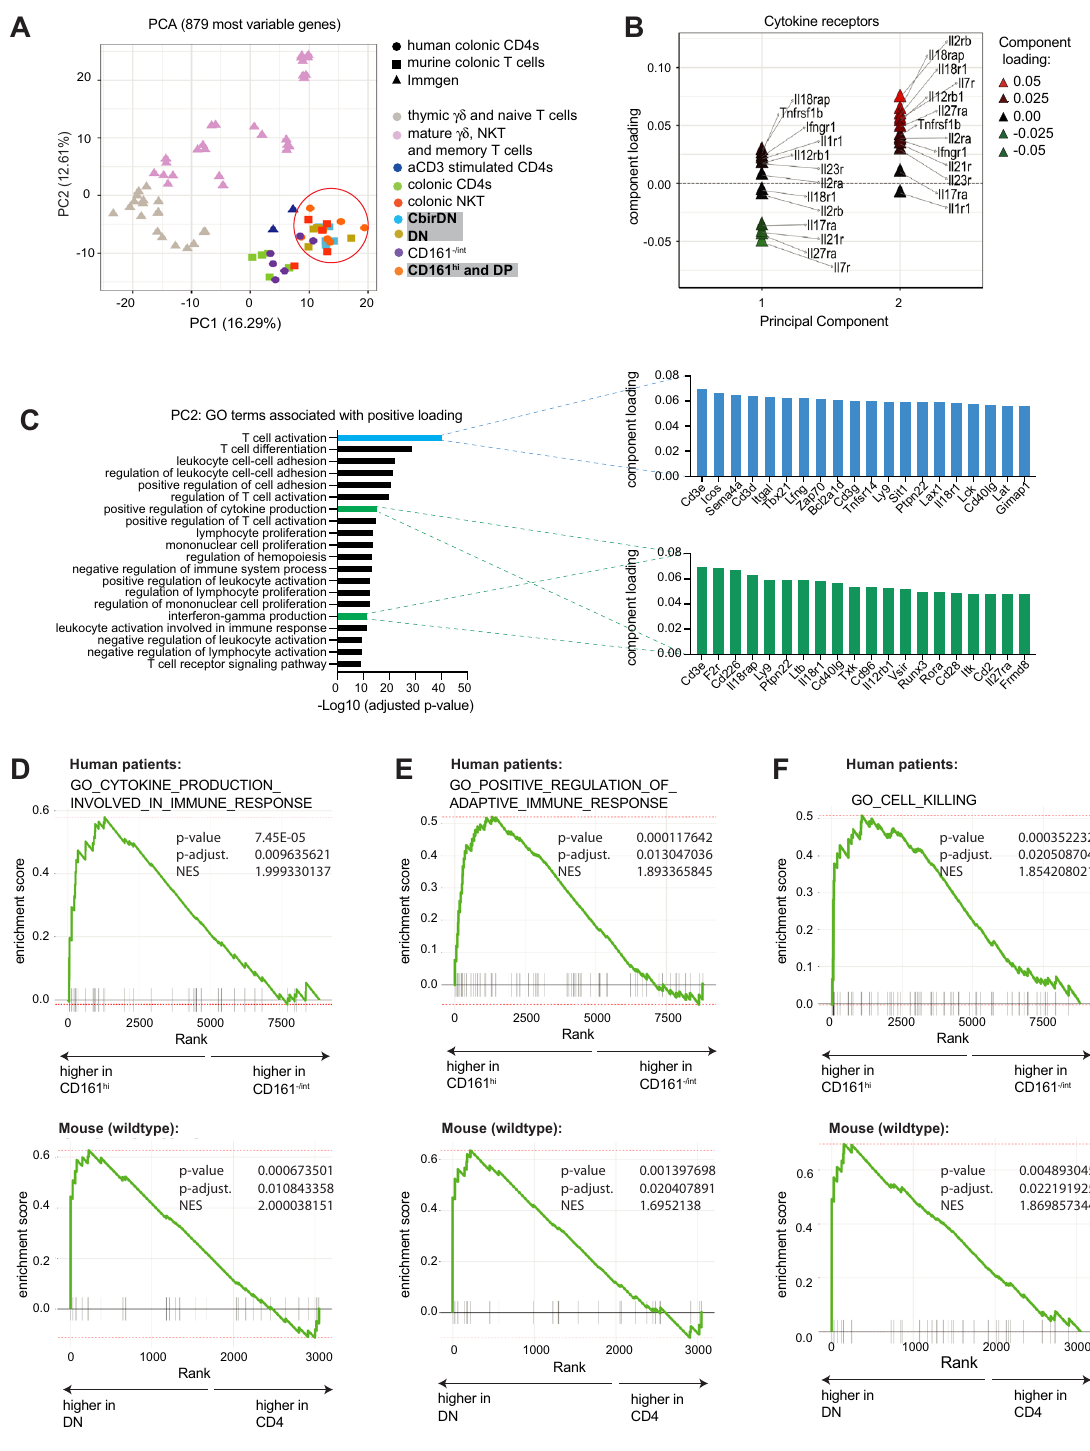
F Human patients: Human patients: Human